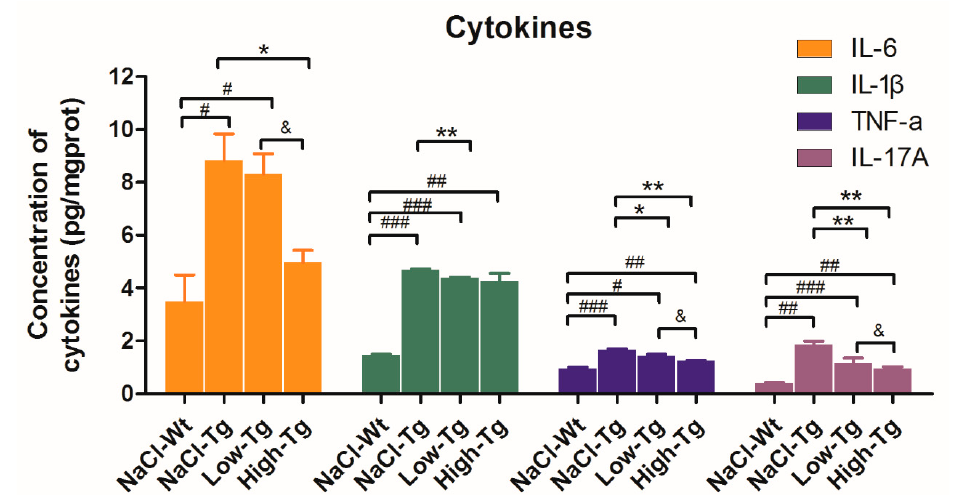
Figure 6. Pro-inflammatory cytokine level in APPswe/PSEN1dE9 mice treated with DhHP-6. Pro-inflammatory cytokines IL-6, IL-1 β , IL-17A, and TNF- α were significantly higher in the brain of AD mice compared to the wild-type mice, and were significantly downregulated after DhHP-6 treatment ( # p < 0.05; ## p < 0.01; ### p < 0.001; * p < 0.05; ** p < 0.01; & p < 0.05).